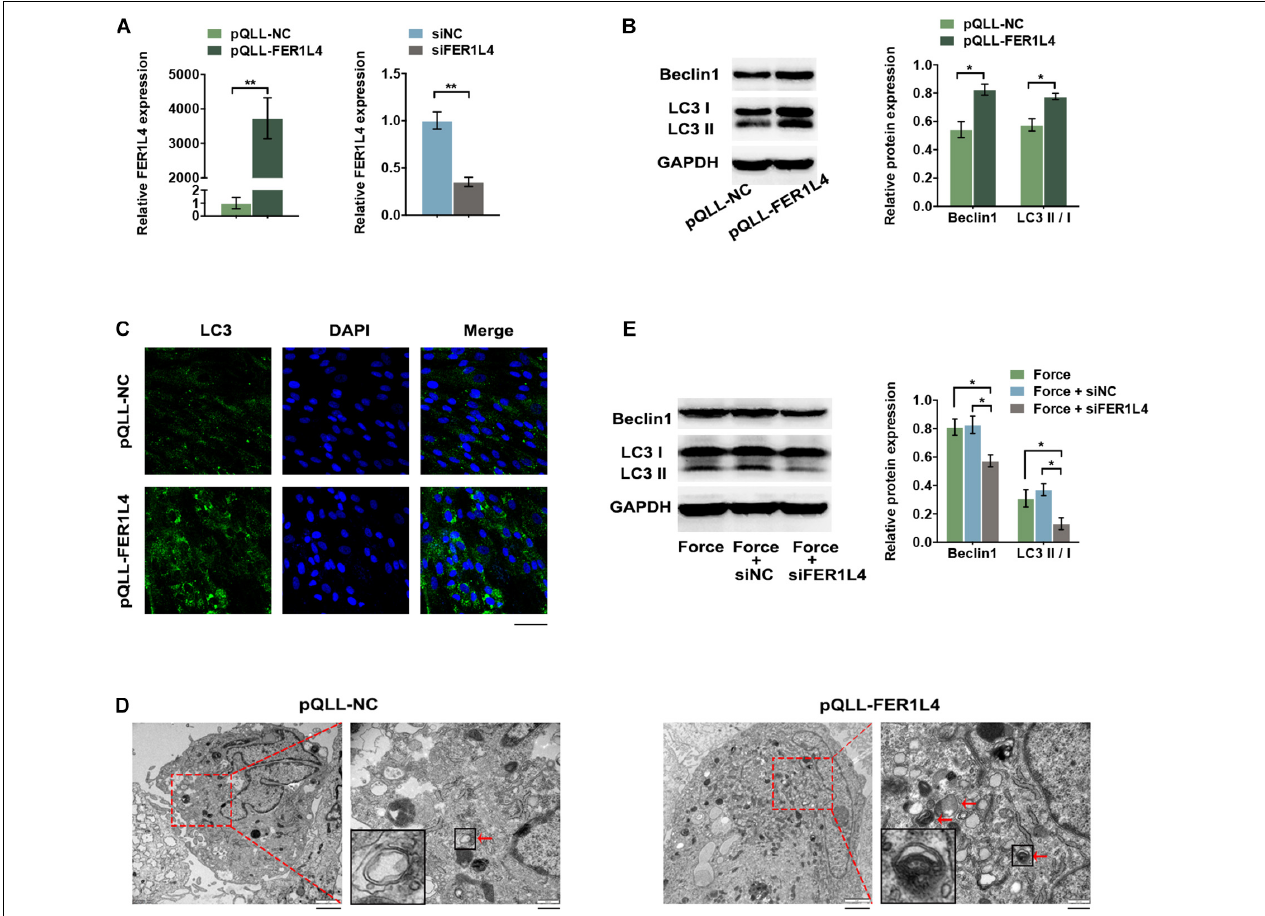
FIGURE 3 | FER1L4 promoted the level of autophagy in PDLSCs. Cells were transfected with FER1L4 vector (pQLL-FER1L4) or FER1L4 siRNA (siFER1L4) to overexpress or knock down its expression. (A) Relative FER1L4 expression in the FER1L4 overexpression and knockdown groups. (B) Western blot analyses of Beclin1 and LC3II/LC3I. Histograms show the quantification of the band intensities. (C) Images of LC3 immunofluorescence staining. Scale bar: 50 µ m. (D) Ultrastructural features assessed by electron microscopy in FER1L4 overexpression group and control group (arrows point to the autophagosomes or autolysosomes). Scale bar: 2 µ m (left) and 500 nm (right). (E) Western blot analyses of Beclin1 and LC3II/LC3I after the application of compressive force with or without FER1L4 knockdown. Histograms show the quantification of the band intensities. Data are presented as the mean ± SD ( n = 3, * p < 0.05; ** p <